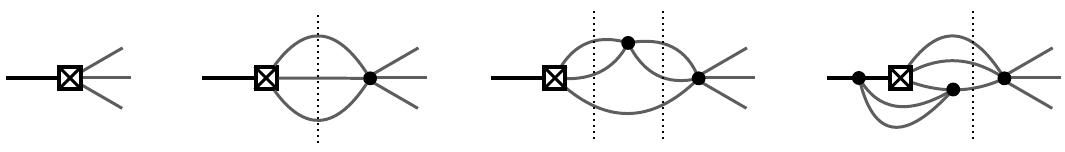
Figure 1 . Examples of the underlying diagrams describing the K → 3 π decay and the correspond- ing finite-volume matrix element. The left-most diagram represents a local one-to-three transition with only exponentially suppressed finite-volume effects. By contrast the middle two diagrams have power-like L dependence due to the on-shell intermediate states, indicated by the vertical dashed line. Finally, the rightmost diagram indicates a strong-interaction induced dressing to the weak vertex. All such interactions, as well as all dressing on the incoming and outgoing vertices are included in the